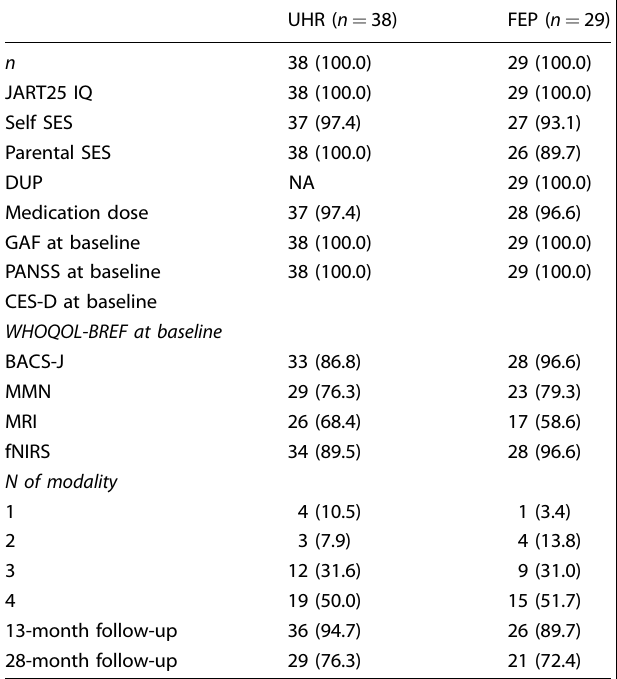
Table 5. Number of data available in this